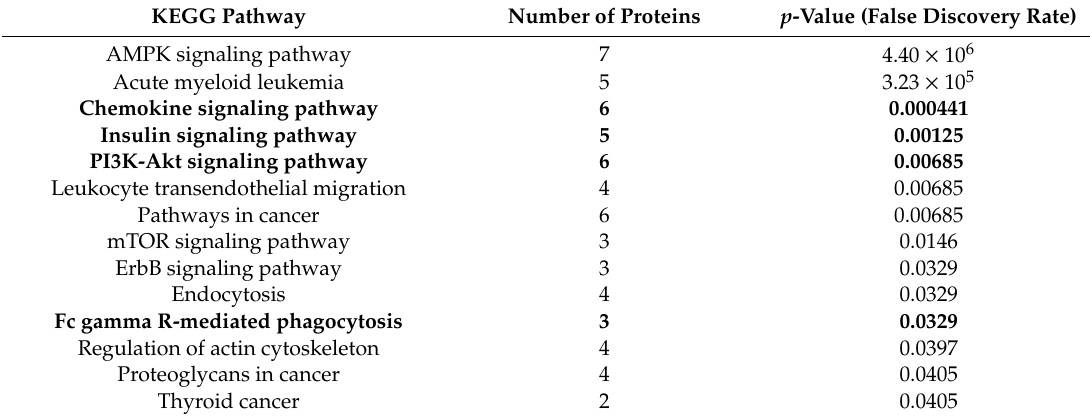
Table 9. KEGG pathways enriched from unique peptides in the postbiotic plus C. perfringens challenge jejunum (compared to postbiotic and C. perfringens